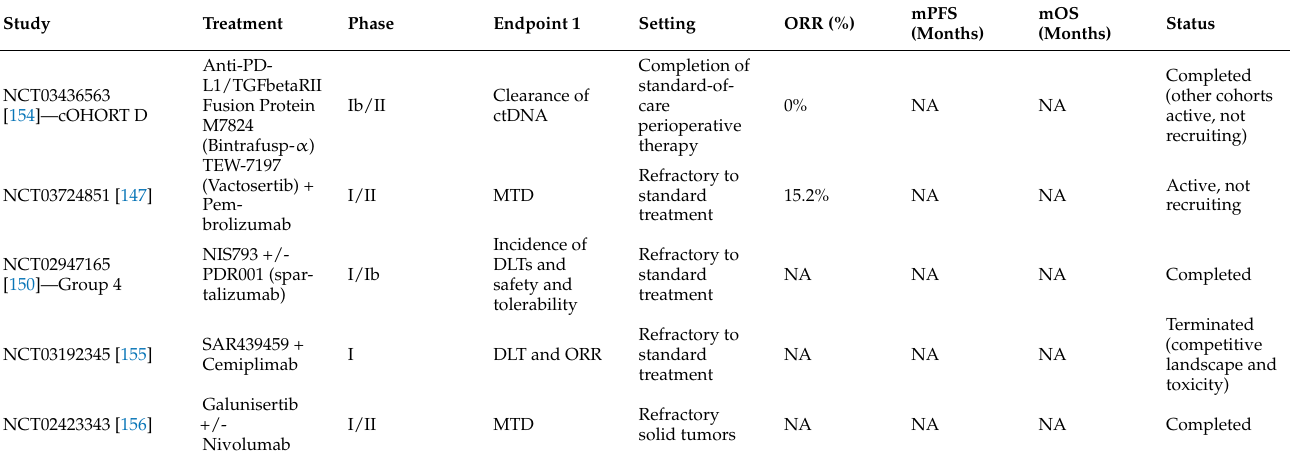
Table 10. Clinical trials including blocking TGF- β , Wnt pathway plus ICIs in MSS